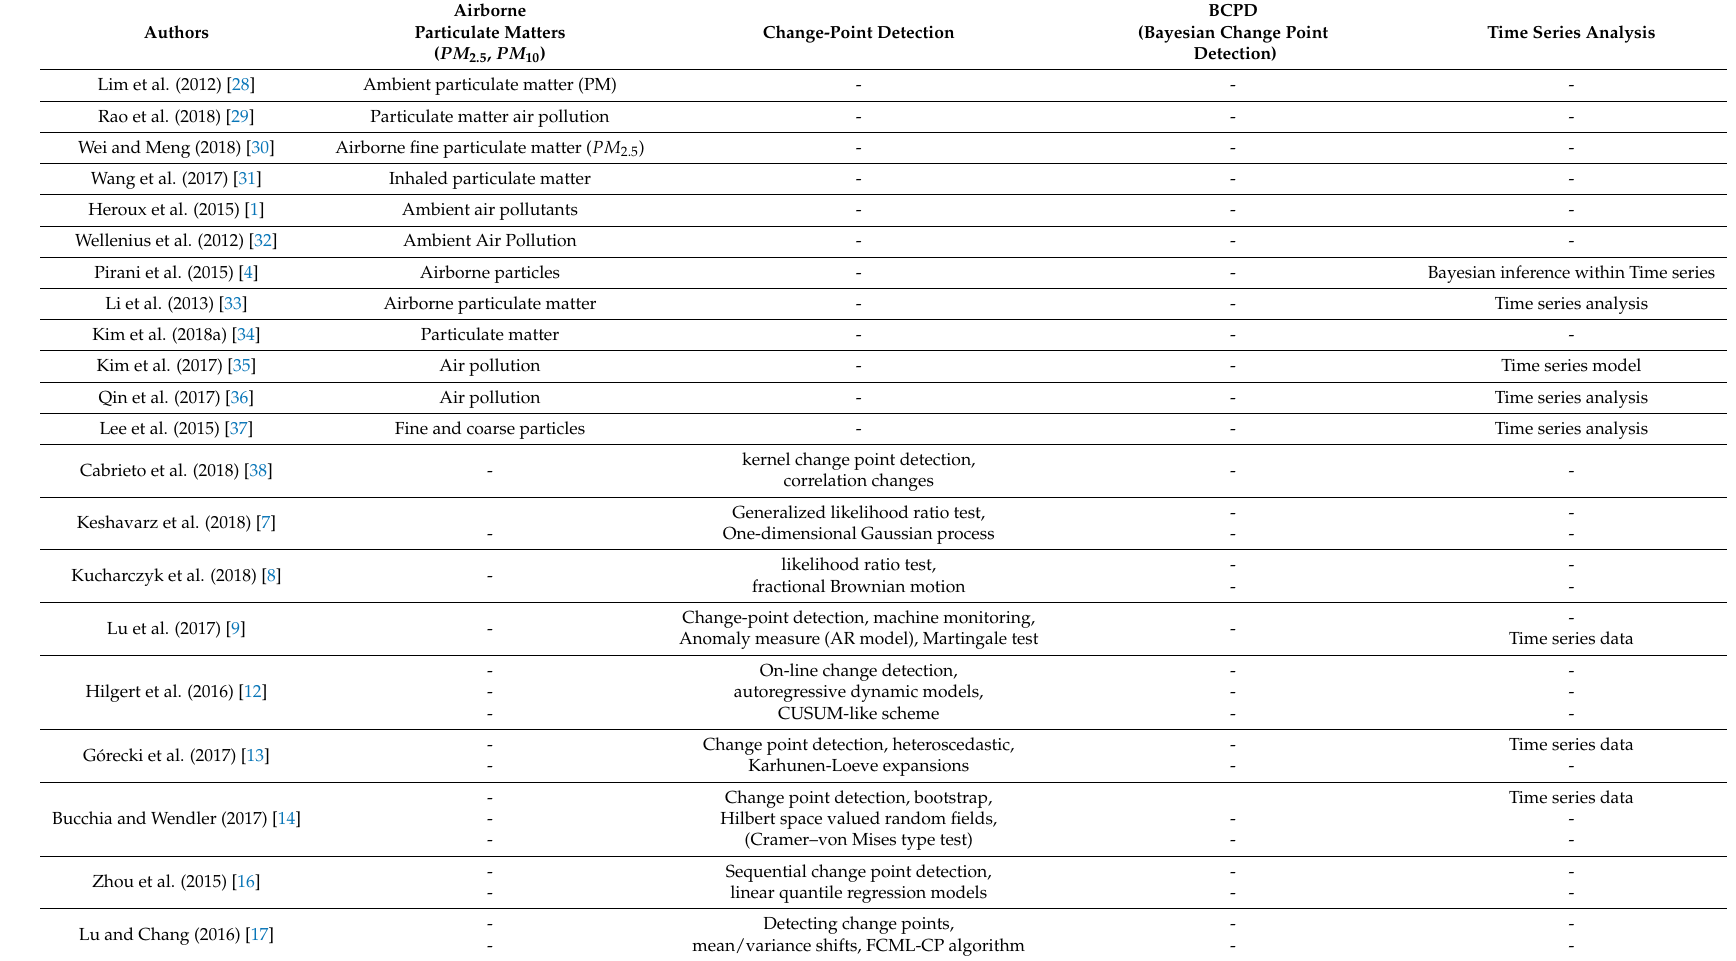
Table 1. Author’s contribution in the direction of